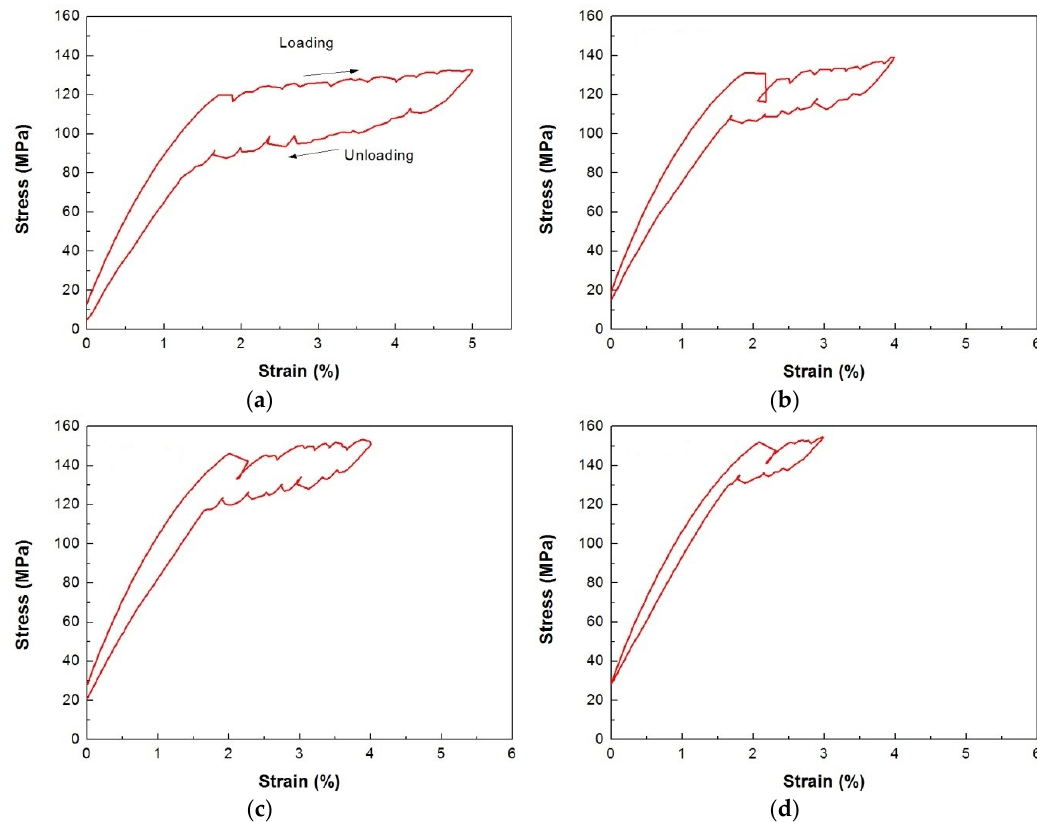
Figure 5. Tensile stress–strain curves of Ni54.9–Mn23.5–Ga21.6 fiber at different temperatures. ( a ) 30 °C; ( b ) 40 °C; ( c ) 50 °C; ( d ) 60 °C.